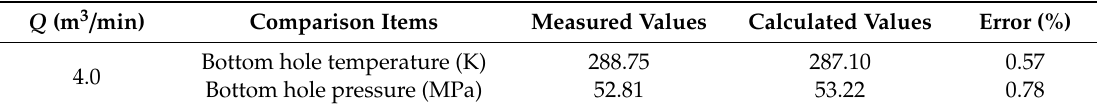
Table 2. Model validation of wellbore flow model (injection pressure is 26.21MPa).